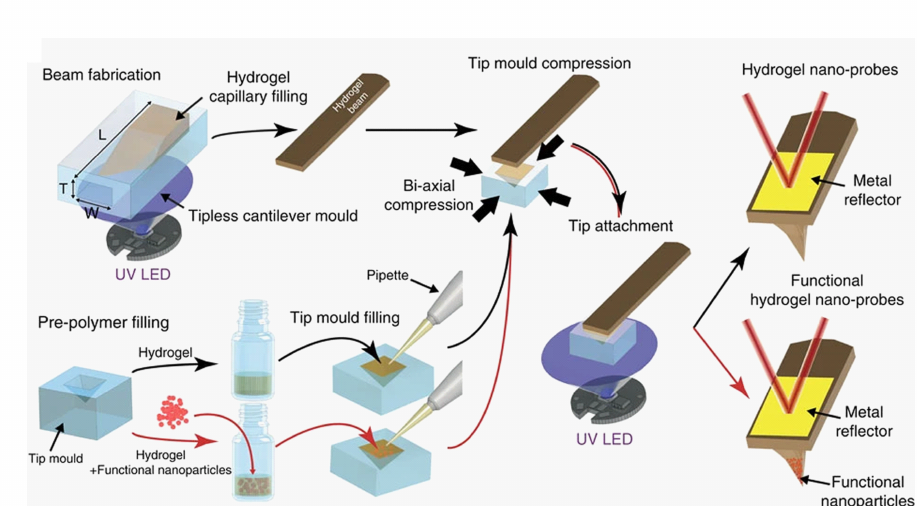
Figure 9. Fabrication method for hydrogel AFM probes. A tipless hydrogel cantilever is first